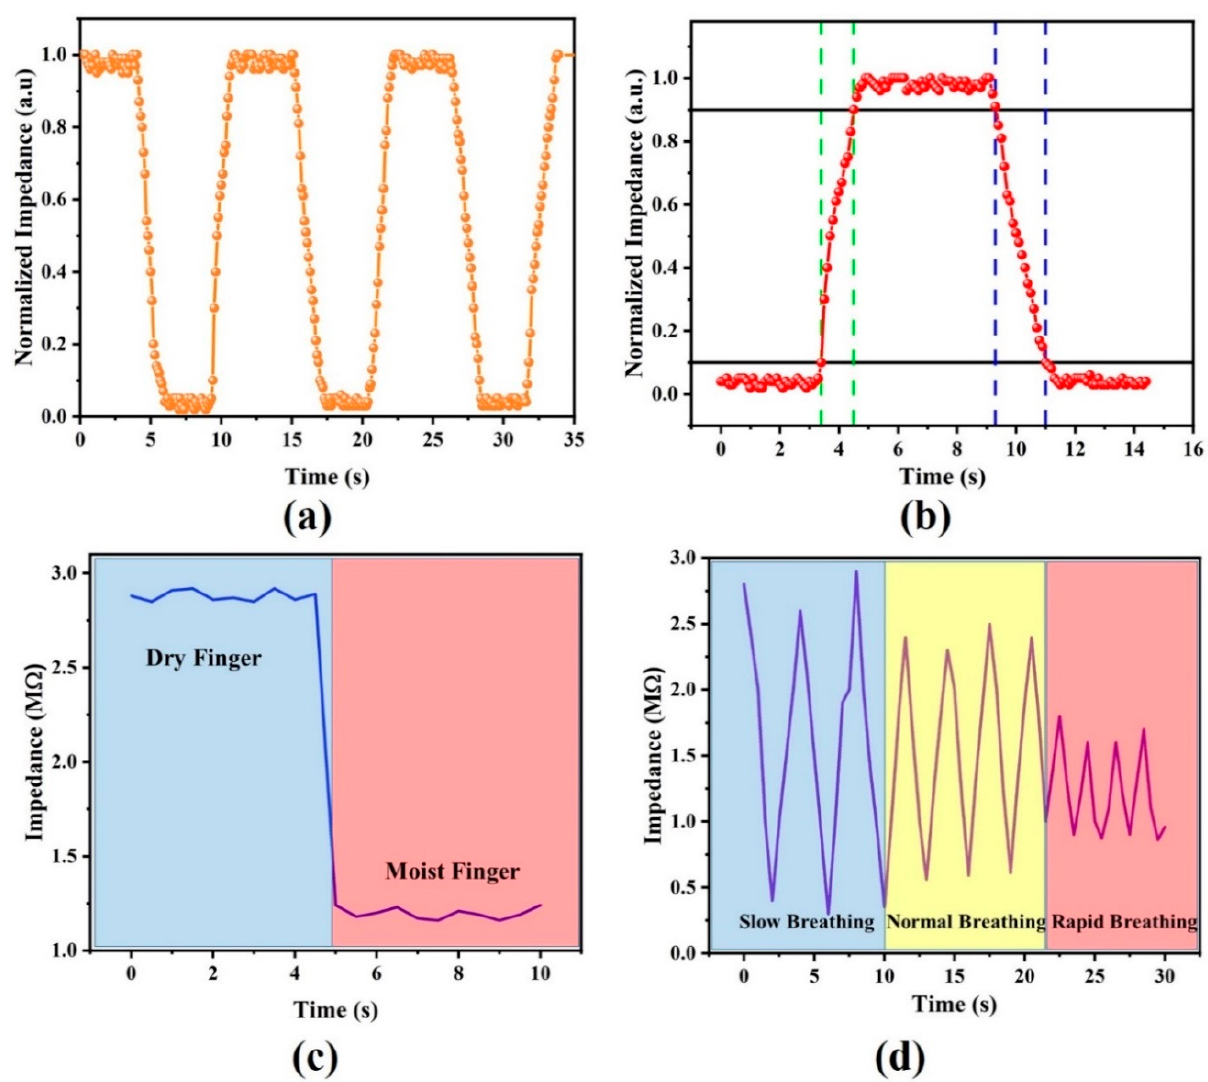
Figure 7. ( a ) Multiple cycles of transient response showing high repeatability of egg white-based humidity sensor. ( b ) Response and recovery time of egg white-based humidity sensor as depicted from a single cycle of transient response. ( c ) Response of egg white-based humidity sensor for dry and moist finger. ( d ) Application of egg white-based humidity sensor for monitoring health, showing its ability to distinguish between slow, normal, and rapid breathing rates.